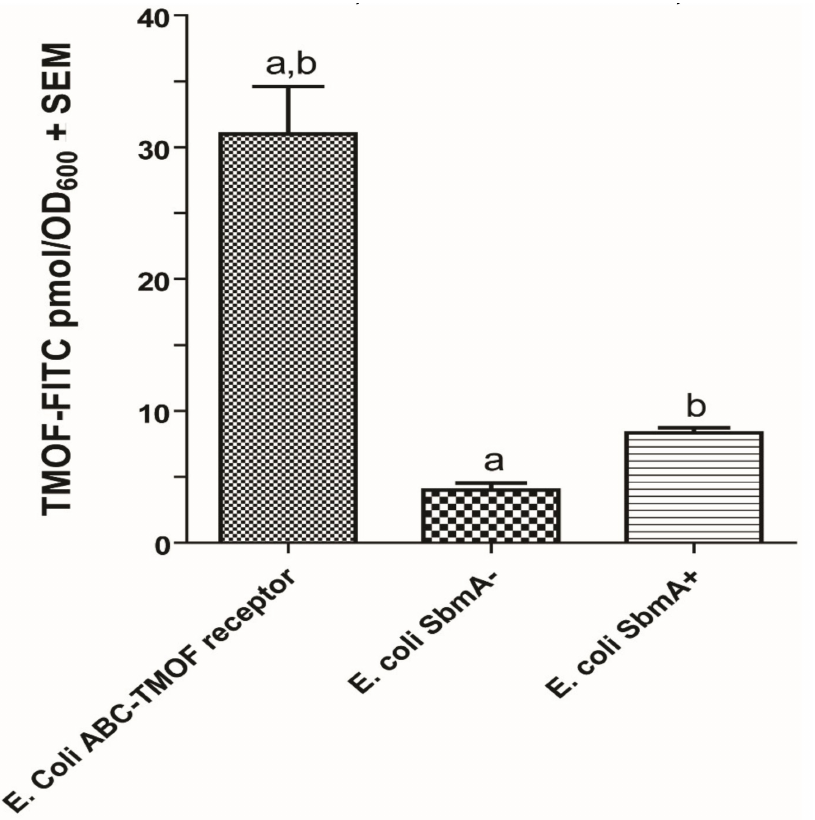
Figure 9. Binding of Aea TMOF-FITC to recombinant E. coli SbmA − cells (8 × 10 8 cells) expressing Aea ABC-TMOF receptor (left bar) in comparison to non-specific binding to E. coli SbmA − cells (middle bar) and low binding to E. coli SbmA + cells (right bar). The bacterial cells were incubated with Aea TMOF for 2 h at 37 ◦ C in M9 medium. The results are expressed as means of three determinations ± SEM. Significant differences were determined using two tailed Student’s t test. a,b Significant differences ( p = 0.0018 and p = 0.0034,